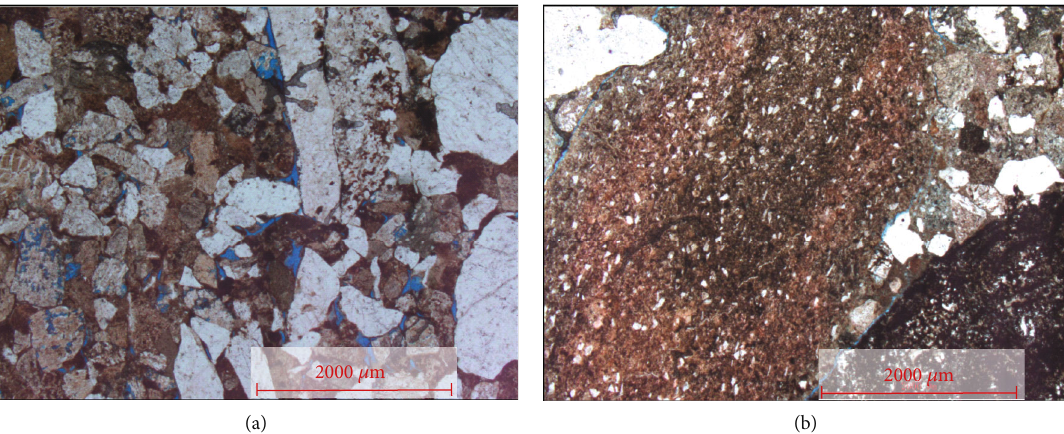
Figure 8: Reservoir physical property characteristics under varied diagenesis processes. (a) Sample no. 26, well Ma19 ( ϕ = 12 : 3 % , K = 75 : 3mD ). (b) Sample no. 2, well Ma603 ( ϕ = 6 : 1 % , K = 0 : 15 mD ).